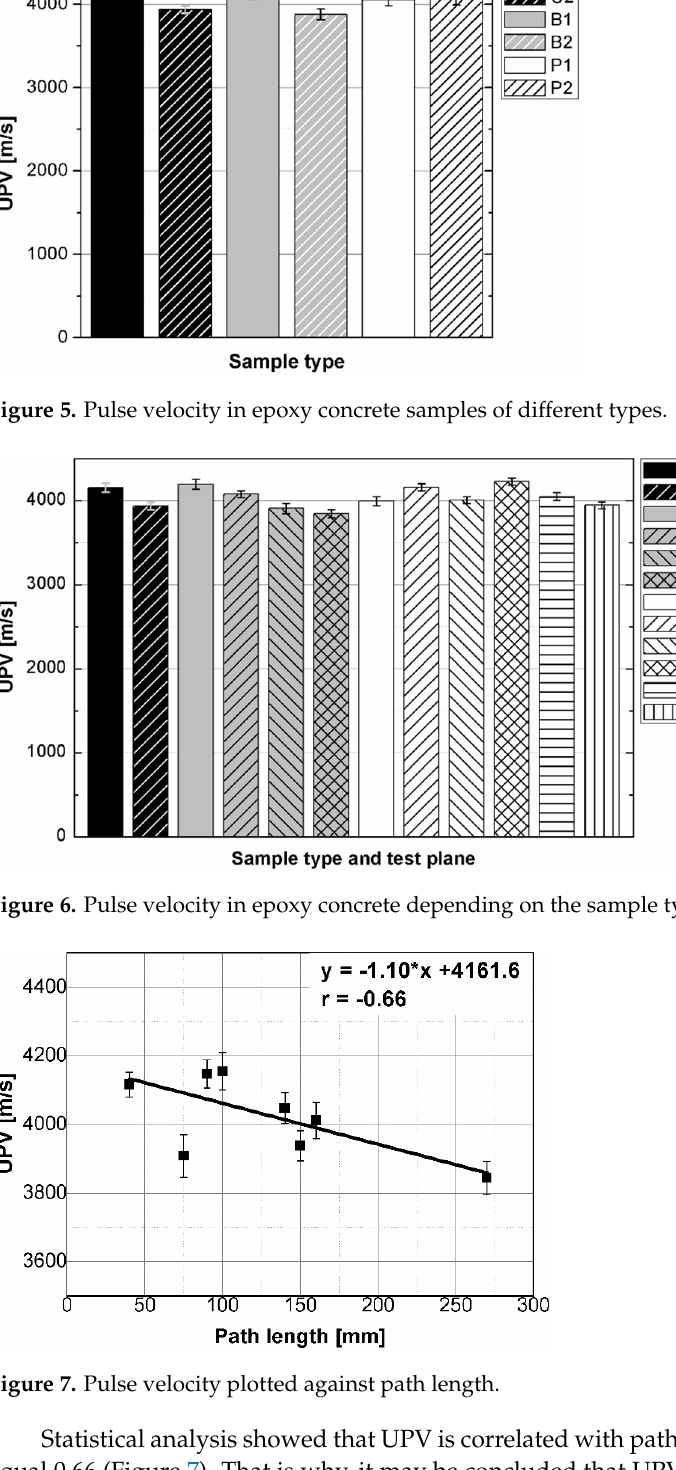
Figure 7. Pulse velocity plotted against path length.